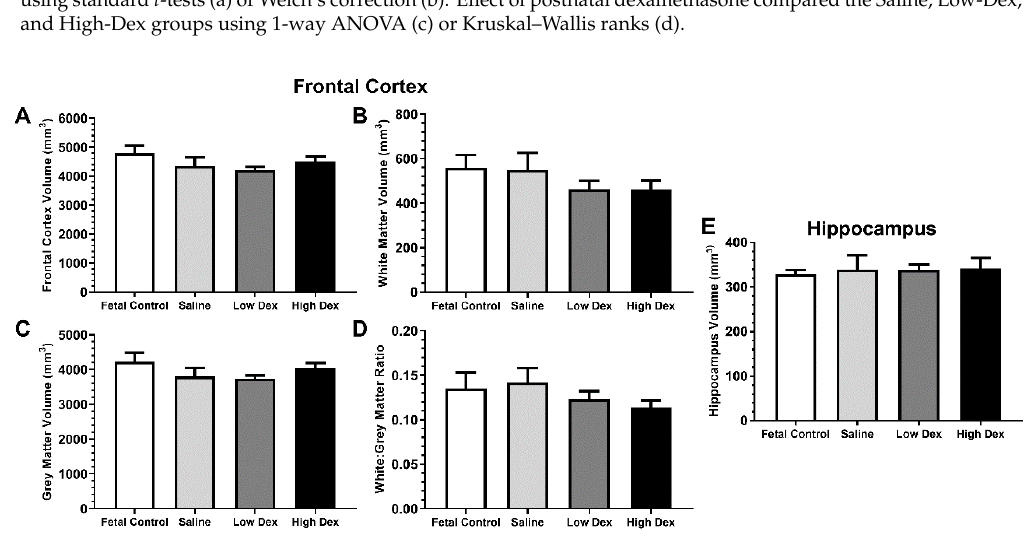
Figure 6. MRI volumetric measurements of the frontal cortex and hippocampus. Frontal cortex ( A ) total volume, ( B ) white matter volume, ( C ) grey matter volume, ( D ) white:grey matter ratio. ( E ) Hippocampus total volume. Bars represent mean + SEM. No significant differences between fetal control and saline, or between preterm groups (all p > 0.05).